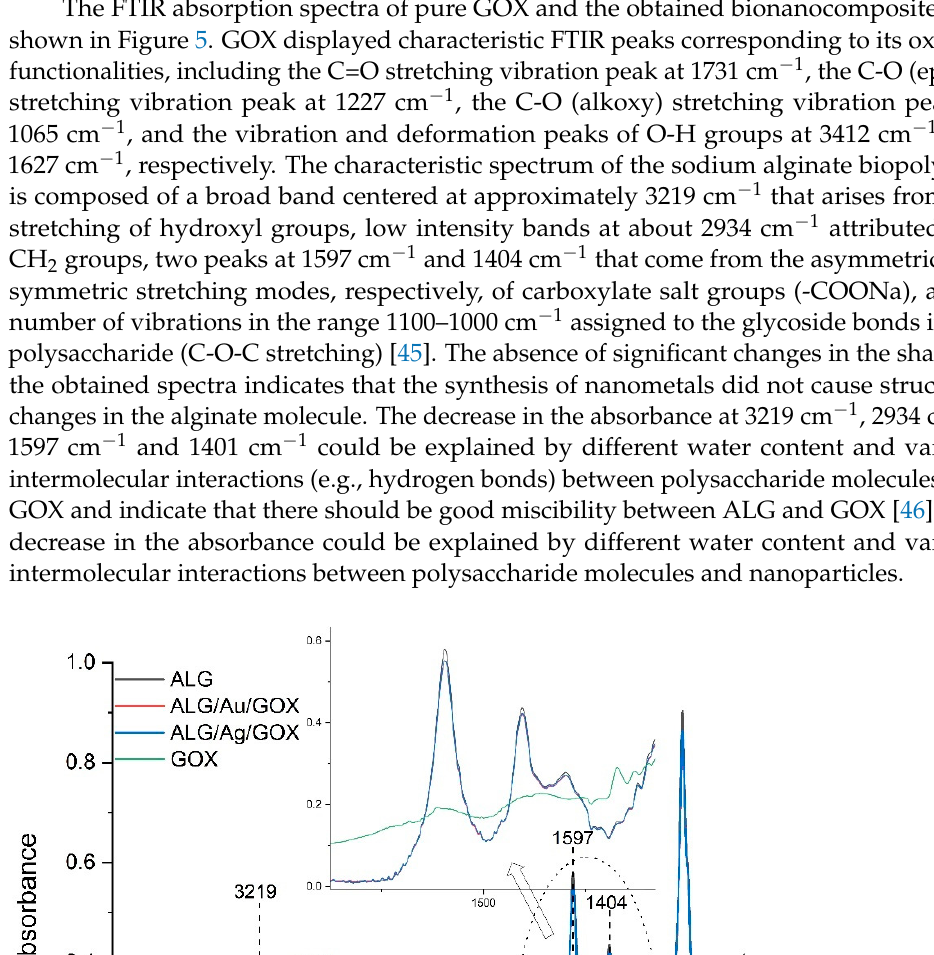
Figure 4. UV–vis spectra of ALG (black line), ALG/Au/GOX (red line) and ALG/Ag/GOX (blue line).